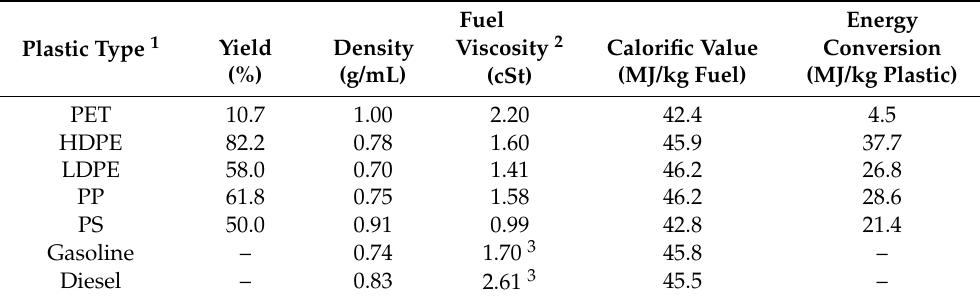
Table 2. Conversion yields and physical parameters of the fuels obtained from different plastic